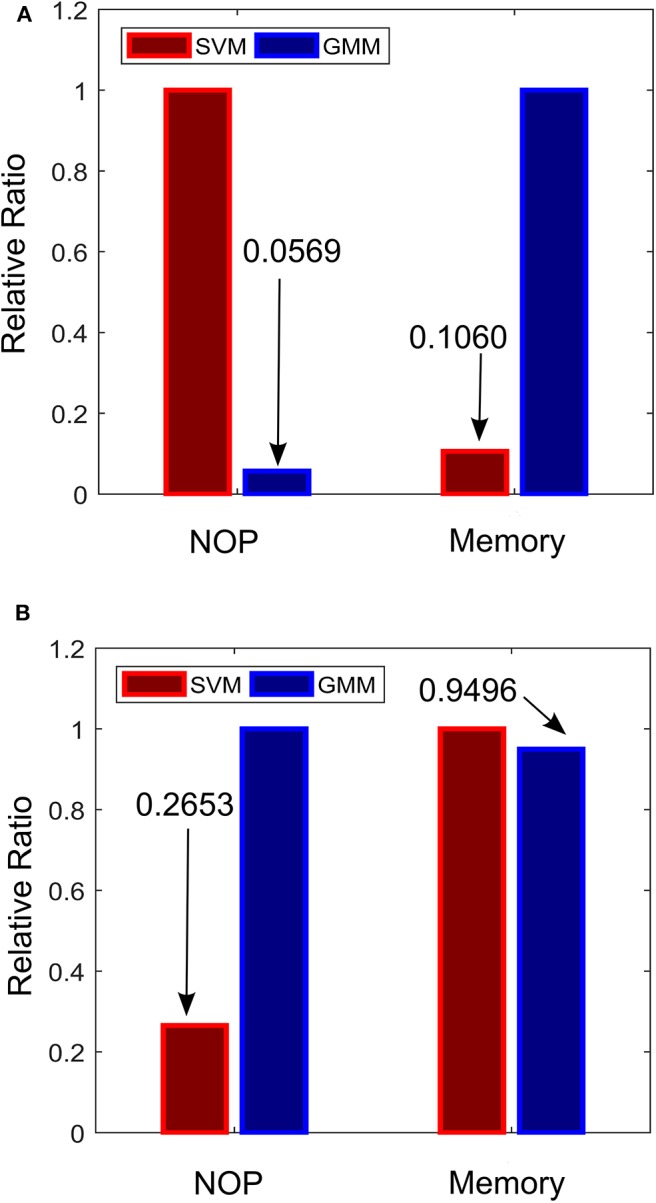
Relative complexity of the critic-actor control driven by GMM and SVM. (A) Normalized complexity for the state estimation stage. (B) Normalized complexity for the fuzzy control stage. Normalized to the maximum for all cases (maximum = 1).